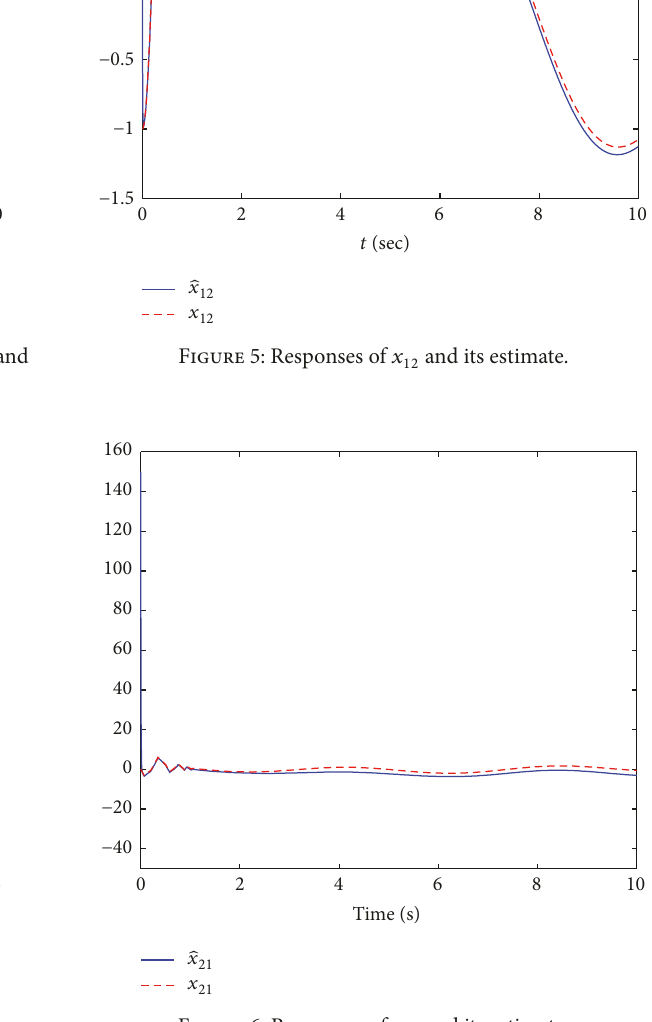
Figure 4: Responses of 𝑥 11 and its estimate.